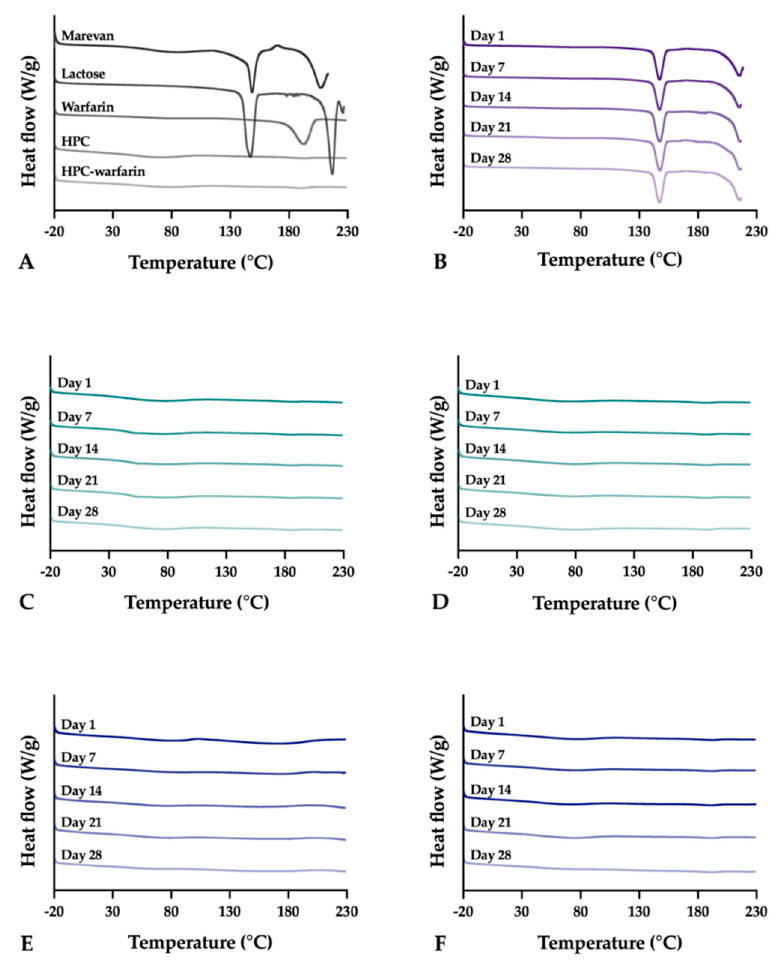
Figure 11. Thermograms (exo up) for ( A ) raw materials and the physical mixture of HPC and warfarin sodium; ( B ) OPS; ( C ) drug-loaded EXT ODF; ( D ) placebo EXT ODF; ( E ) drug-loaded IJP ODF; and ( F ) placebo IJP ODF over a one-month period .